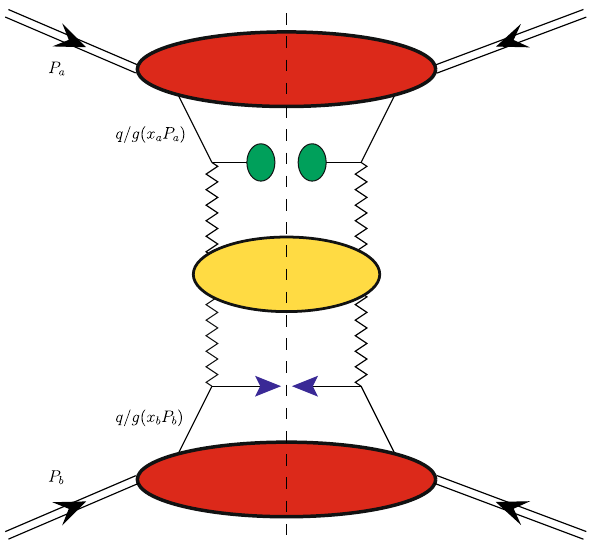
Fig. 2 Hybrid high-energy/collinear factorization for the inclusive quarkonium + jet production. Red blobs refer to proton collinear PDFs, green blobs stand for quarkonium single-parton FFs, while blue arrows denote a light-flavored jet emission. The BFKL ladder, given by the yellow blob, is connected to impact factors via Reggeon (zigzag) lines. Diagrams were done by making use of the JaxoDraw 2.0